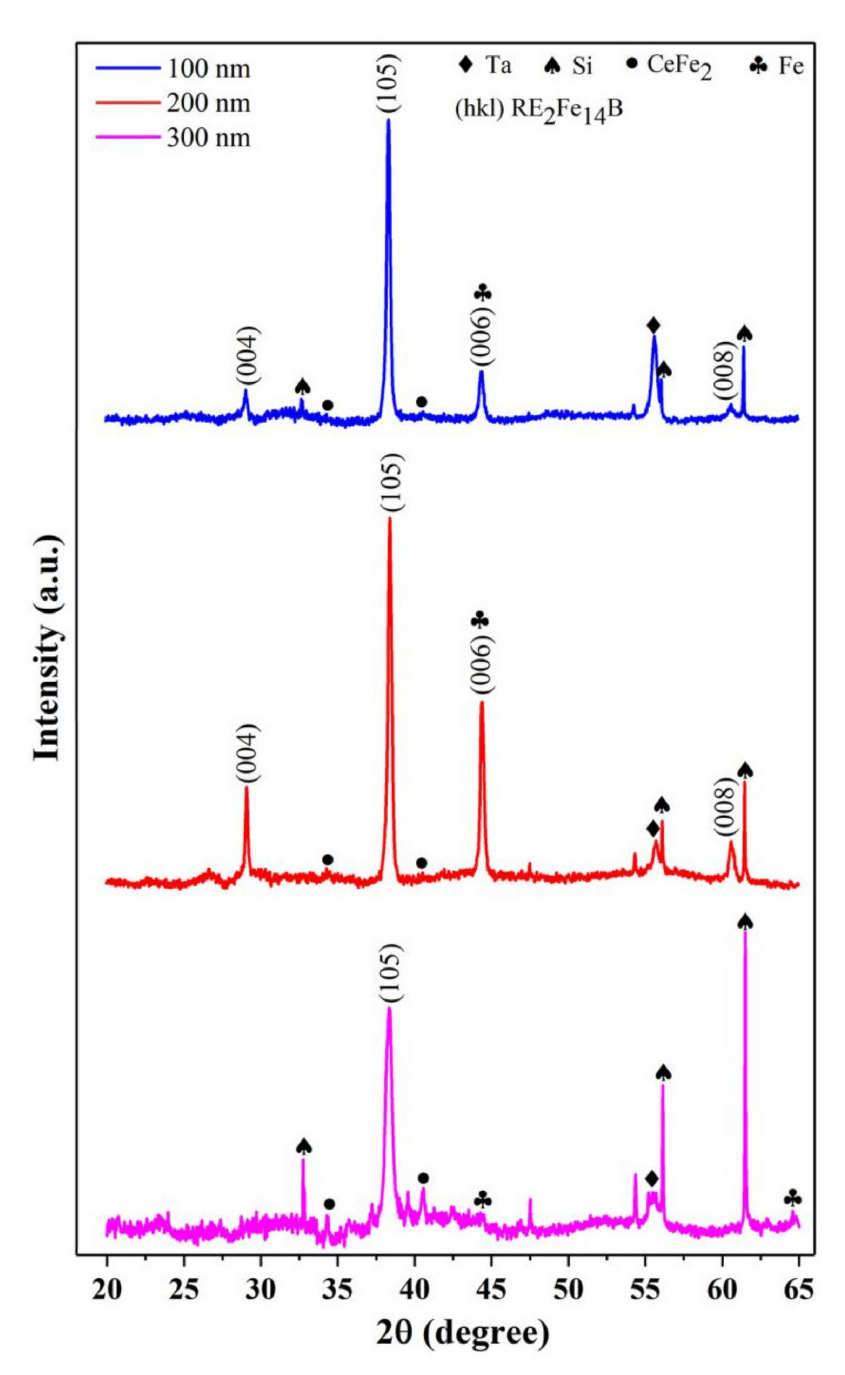
Figure 4. XRD patterns of Ta (50 nm)/Nd 6.19 Ce 7.98 Fe 75.48 B 10.35 (t Nd-Ce-Fe-B nm)/Ta (50 nm) films